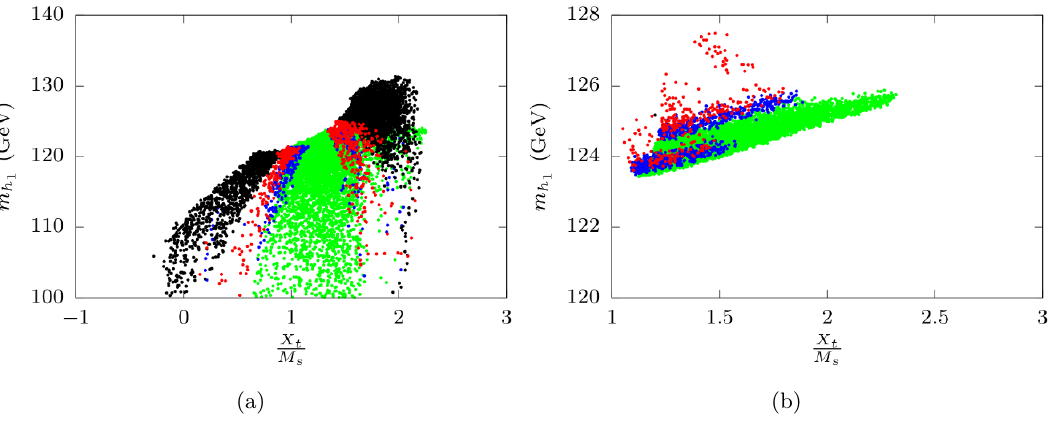
Figure 3 . The vacuum stability pro(cid:12)le is plotted in X t p and M s = m ~ m ~ with tree level stop masses. The left (right) plot corresponds to 5 (cid:20) tan (cid:12) (cid:20) 10 t 1 t 2 (40 (cid:20) tan (cid:12) (cid:20) 50). Green and blue regions correspond to stable and long-lived vacuum respectively. The red (black) points refer to thermally excluded (quantum mechanically unstable) vacuum.